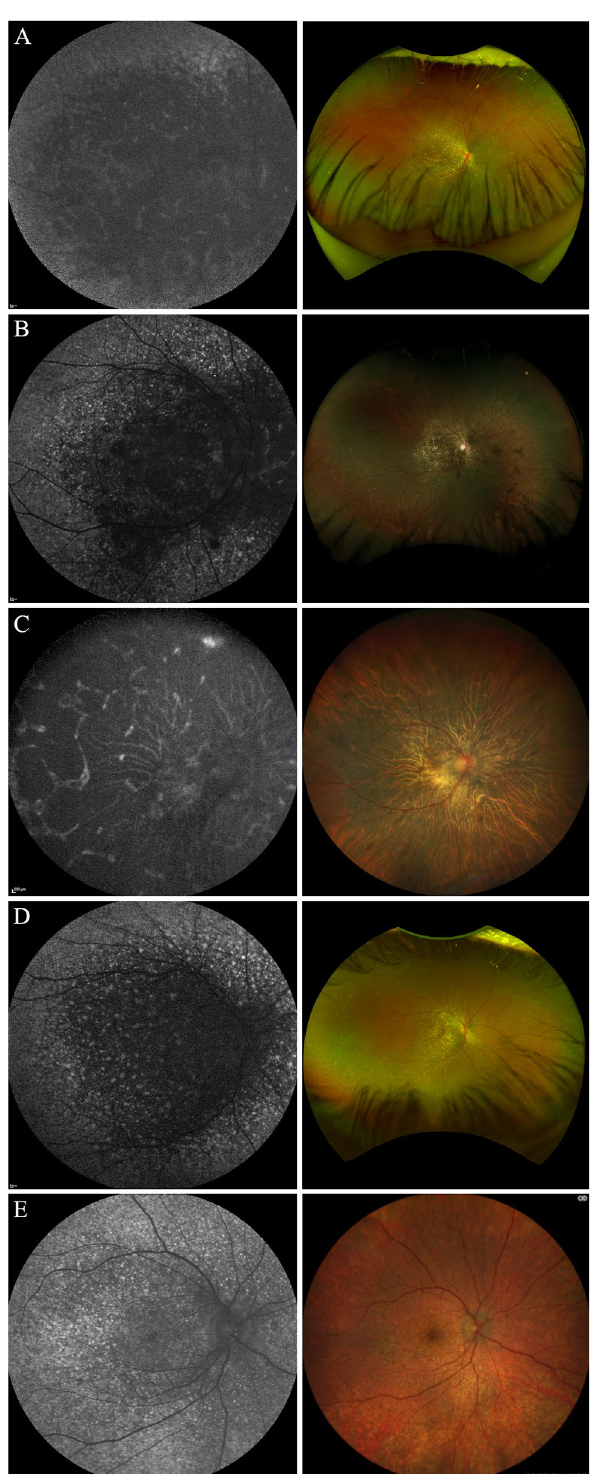
Figure 2. Short-wave autofluorescence (SW-AF) and color fundus photos of five patients with BCD. ( A–E ) Left column: SW-AF images reveal RPE atrophy. ( A,B,D,E ) Right column: color fundus images demonstrate yellow- white, shiny crystalline deposits in the posterior pole of patients 1, 2, 4, and 6,